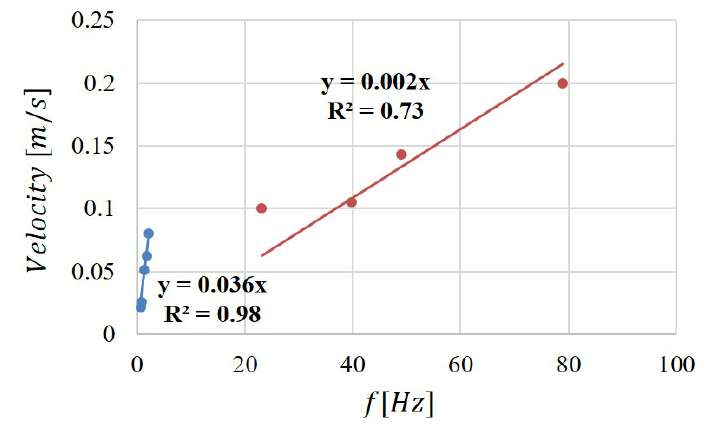
Figure 7. The water velocity plotted versus the water frequency for F ∈ { 0.1,0.2,0.3, 0.4,0.5 } mL/min (blue dots) and versus the air frequency for F ∈ { 0.6,0.7,0.8,0.9 } mL/min (red